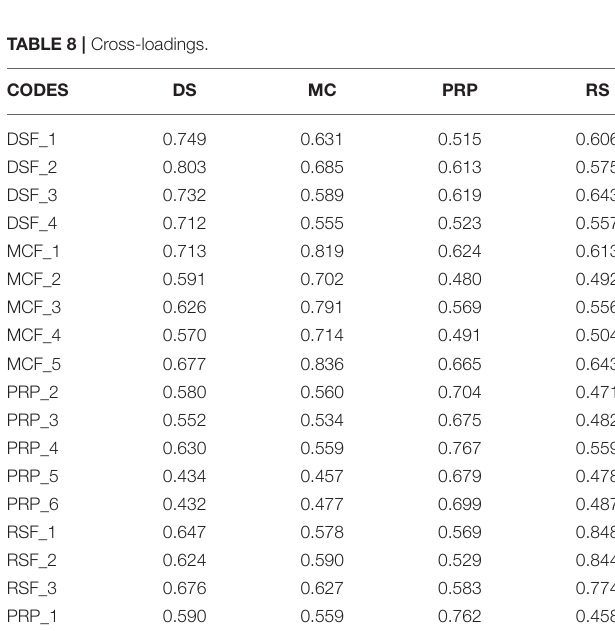
FIGURE 2 | Algorithm model.